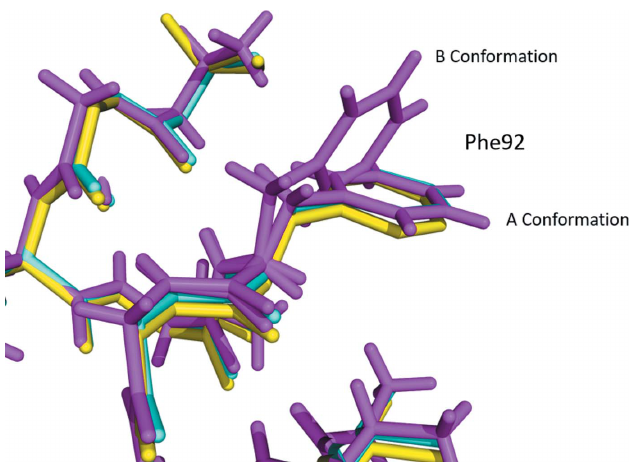
Figure 2 An overlay of the various conformations of Phe92 seen in the structure of the open form of NaK, colored yellow (PDB code 3e8h; Alam & Jiang, 2009 b ); the open form of NaK2K, colored cyan (PDB code 3ouf; Derebe et al. , 2011); and our atomic resolution structure of the open form of NaK2K, colored magenta (PDB code